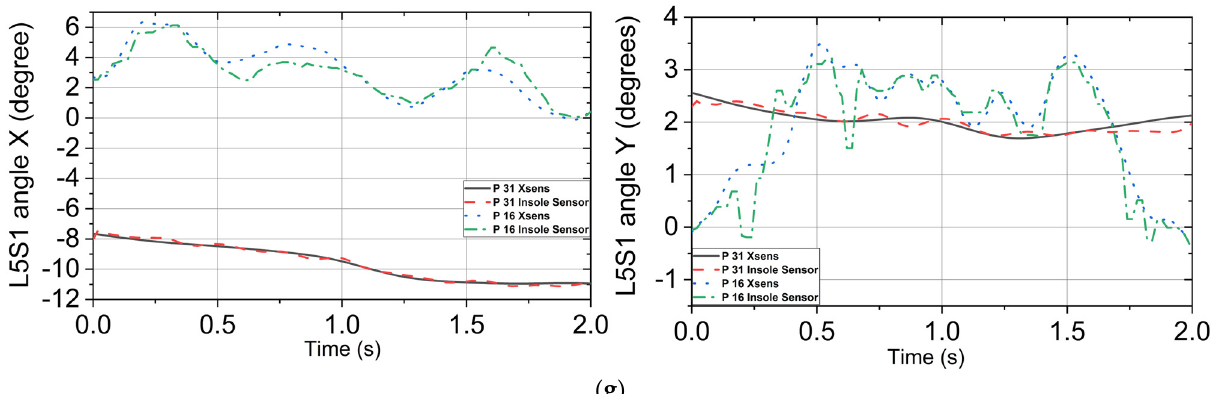
Figure 7. Joint angle detection in the X and Y axes from the ankle to the L5S1 joint, which is located above the pelvis for participants 31 and 16. ( a ) Left ankle angle actual vs. predicted in the X − axis and the Y − axis. ( b ) Right ankle angle actual vs. predicted in the X − axis and the Y − axis. ( c ) Left knee angle actual vs. predicted in the X − axis and the Y − axis. ( d ) Right knee angle actual vs. predicted in the X-axis and the Y-axis. ( e ) Left hip angle actual vs. predicted in the X − axis and the Y − axis. ( f ) Right hip angle actual vs. predicted in the X − axis and the Y − axis. ( g ) L5S1 angle actual vs. predicted in the X − axis and the Y − axis.